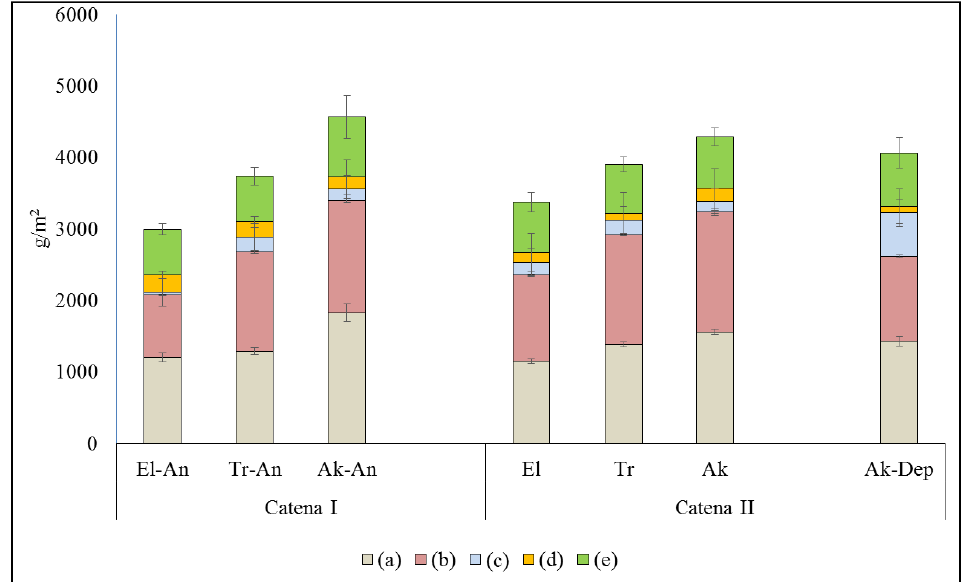
Figure 4. Contribution of live and dead plant organic matter in the above-ground ((e) — green phytomass, (d) —“ vetosh ” 1 , (c) —“ litter ” 2 ) and below-ground ((b) — live, (a) — dead) fractions of biomass in g/m 2 . 1,2 , dead plant organic materials (of different rates of decomposition) accumulated on land-surface in different ecosystems, where 1 , vetosh is slightly decomposed plant organic matter that remains the structure of original plant materials and still connected with plants; 2 , litter is moderately decomposed plant organic matter that is starting to become the soil organic